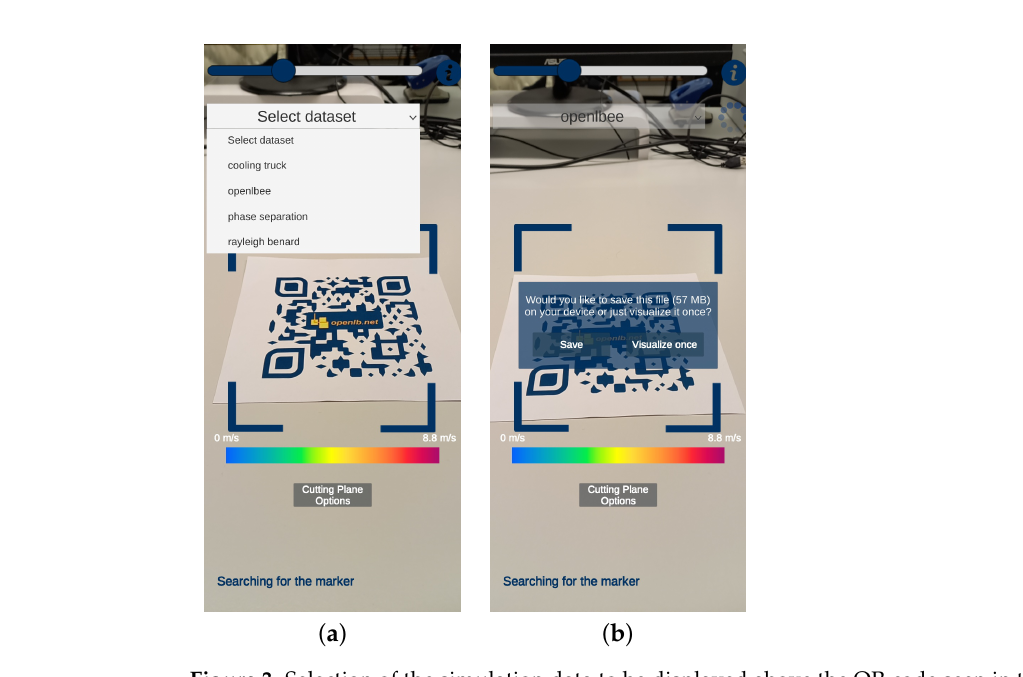
Figure 3. Selection of the simulation data to be displayed above the QR code seen in the background. ( a ) Data selection options that can be viewed. ( b ) Data selection user prompt to decide how to handle large files.